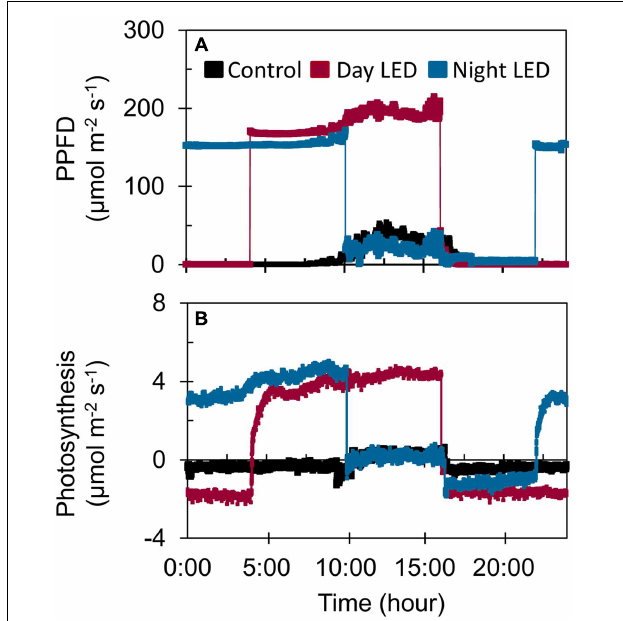
FIGURE 3 | The effect of LED inter-lighting on (A) diurnal photosynthetic photon flux density (PPFD) and (B) photosynthetic rate. Measurements were made on 14 February using fully expanded mid-canopy leaves from control plants and plants exposed to daytime or nighttime LED inter-lighting treatments. Daytime LED inter-lighting was provided from 4:00 am to 4:00 pm and nighttime from 10:00 pm to 10:00